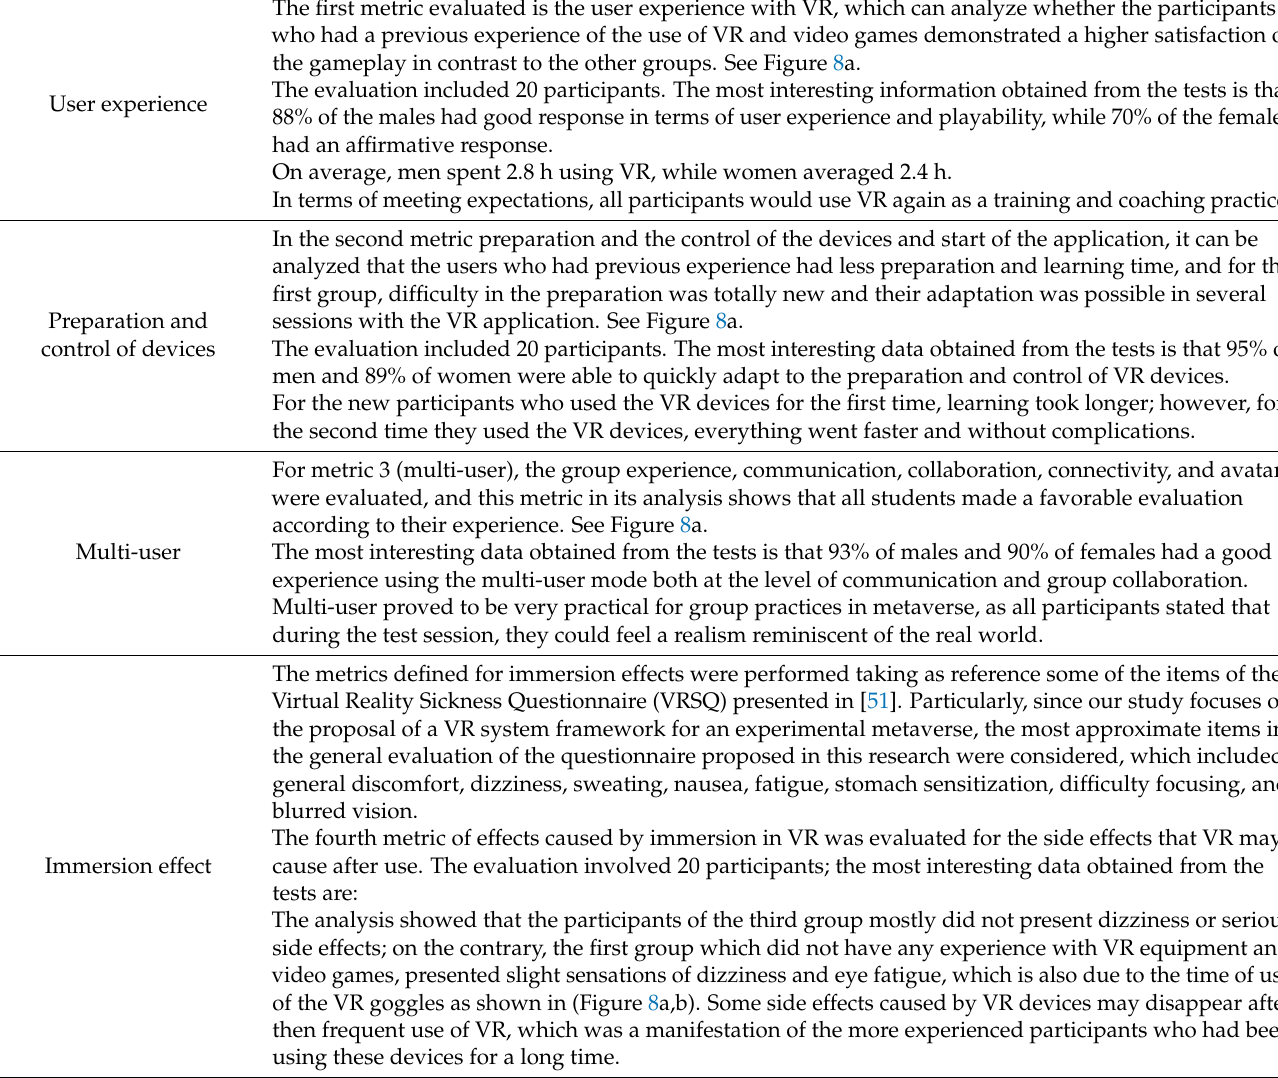
Table 5. Main metrics evaluation